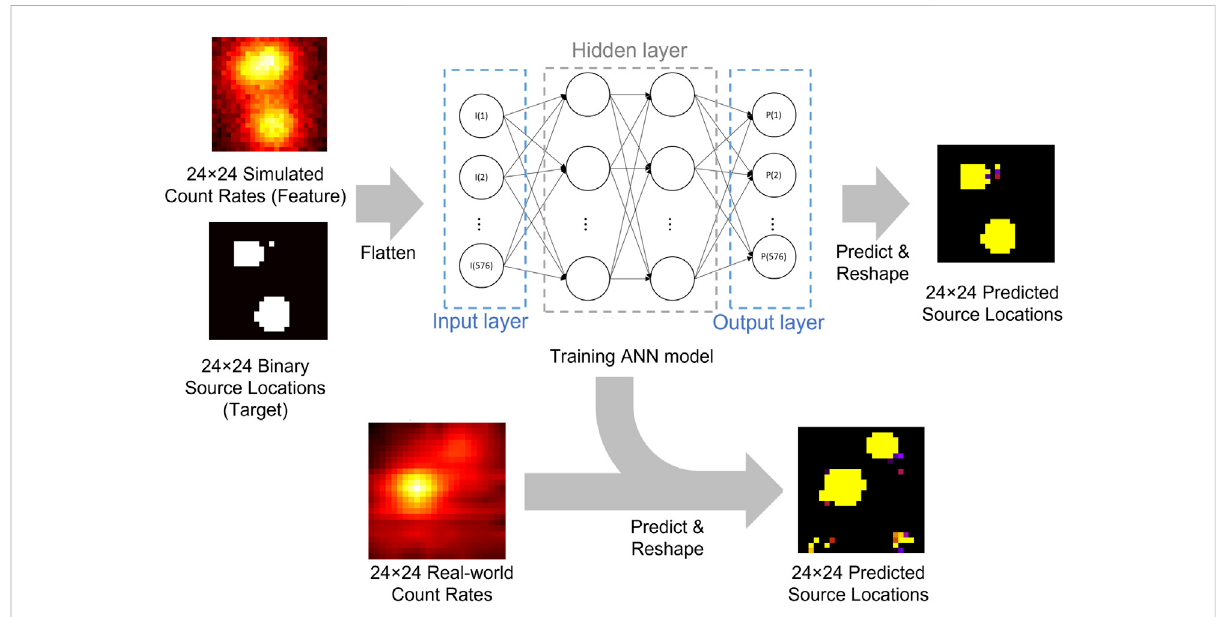
FIGURE 1 Conceptual diagram of the hotspot investigation